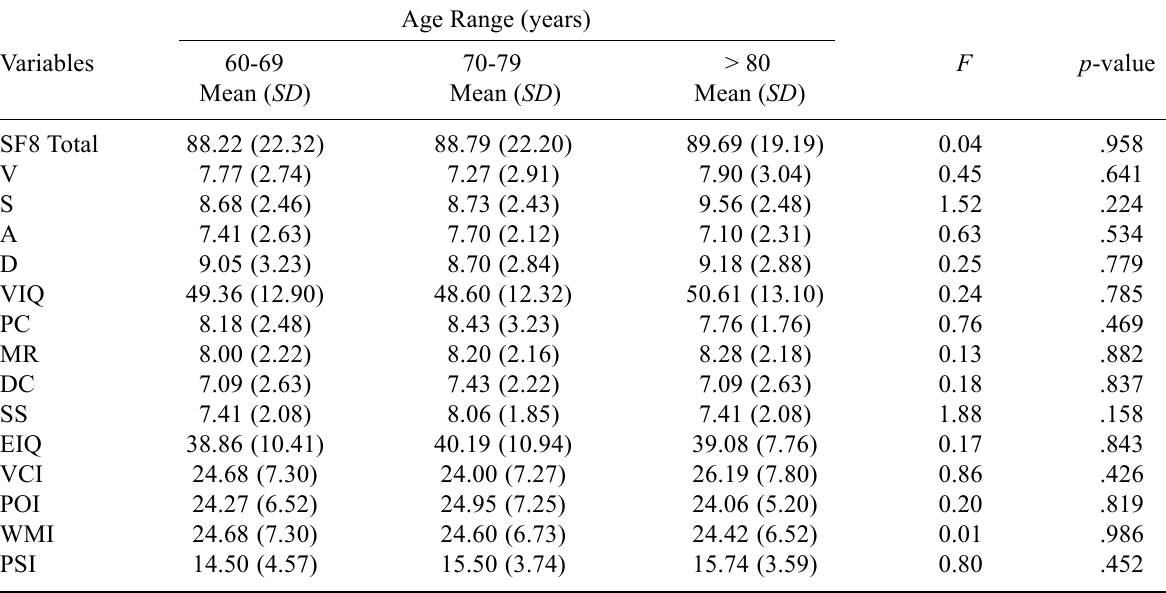
Cognitive Performance of Group 1 According to Age Range